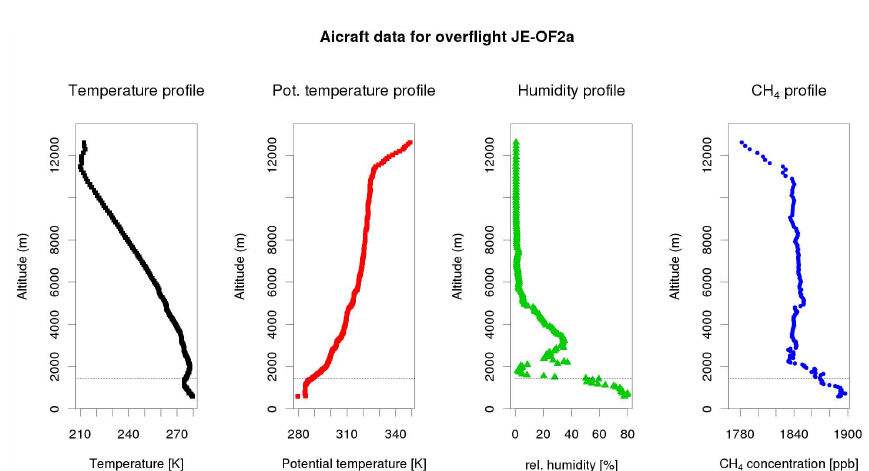
Fig. 3. CH 4 , H 2 O and temperature data from aircraft in-situ measurements obtained during the overflight JE-OF2a. The potential temperature was calculated from the temperature and pressure profile. The dashed line illustrates the calculated boundary layer height. At the time of the overflight the boundary layer height at Jena was approximately